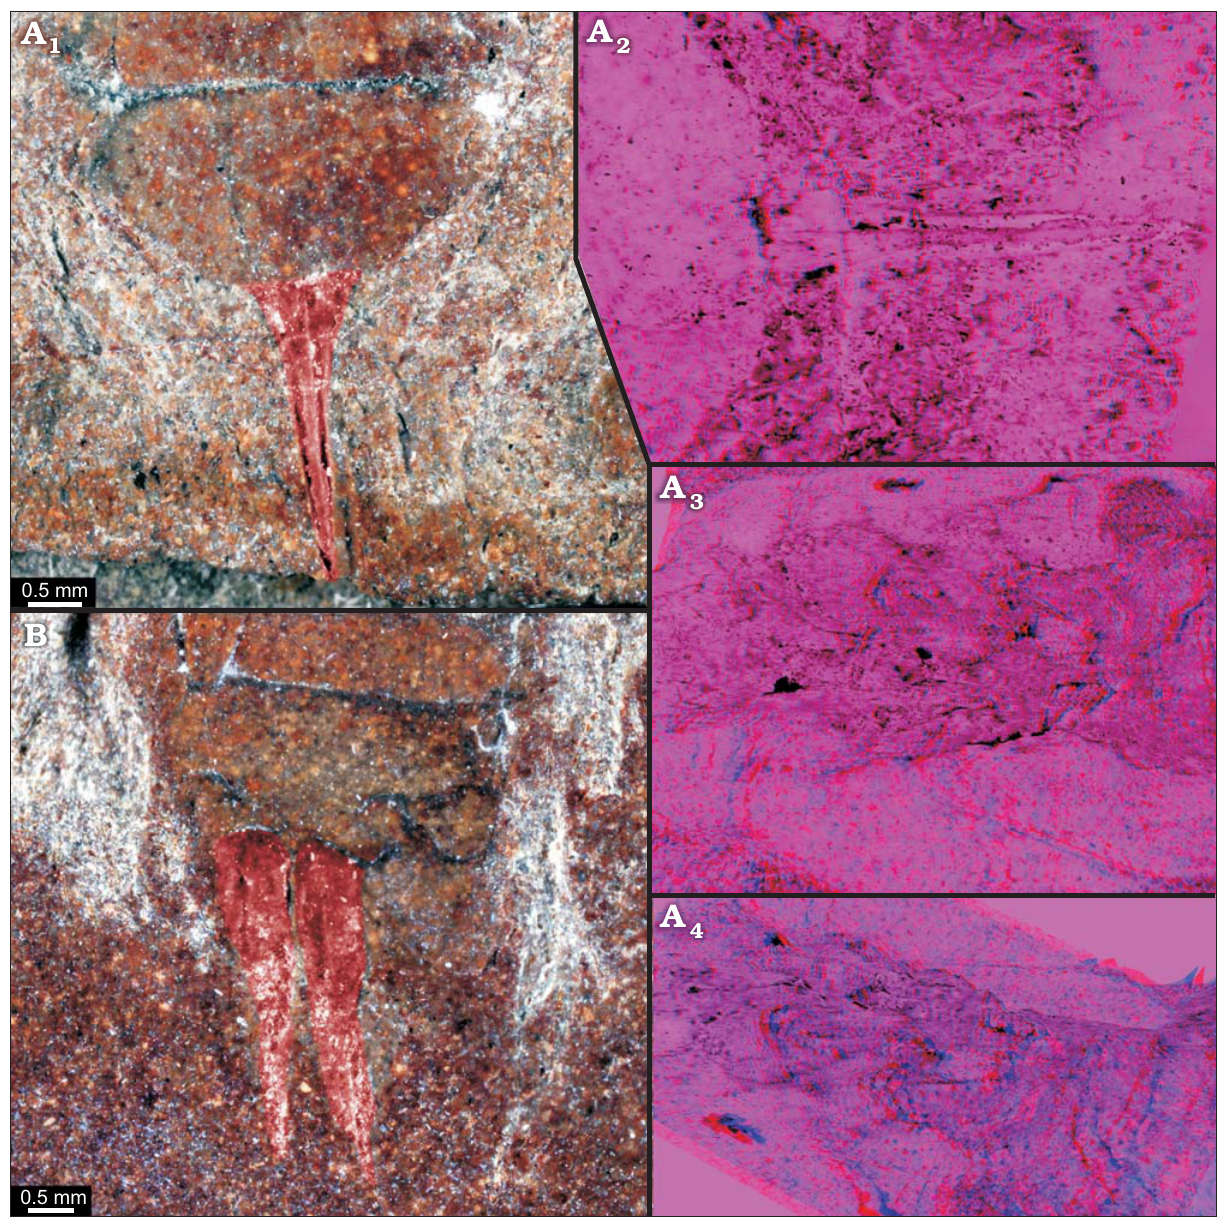
Fig. 5. Roachoid nymphs YPM IP 000057 ( A ) in ventral view and YPM IP 027872 in dorso-lateral view ( B ) with interpretations of preserved structures. A 1 , B, colour-marked close-up image of ovipositor; A 2 , stereo close-up image of the ovipositor; A 3 , A 4 , stereo close-up images of thorax with visible parts of the coxae (red-cyan stereo-anaglyphs; please use red-cyan glasses to